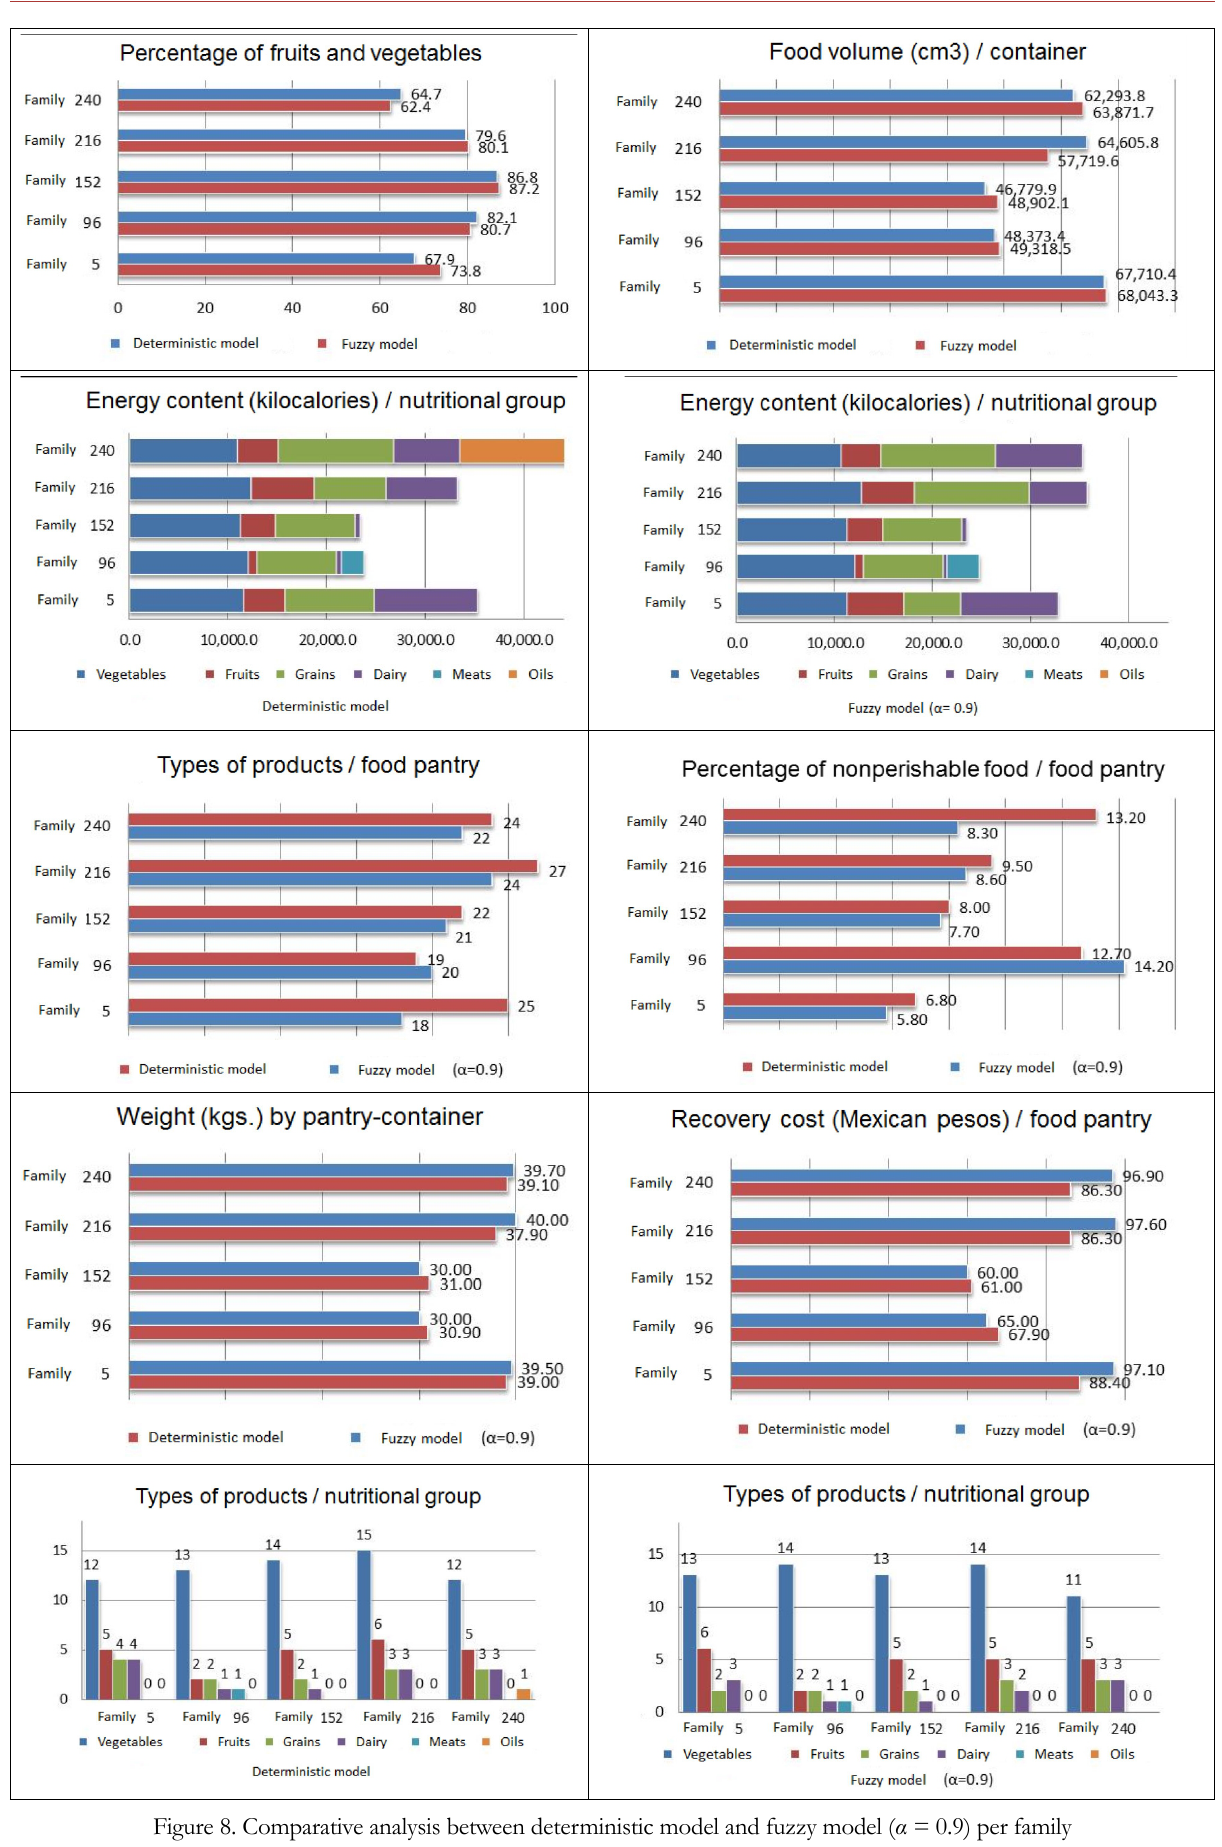
Figure 8. Comparative analysis between deterministic model and fuzzy model ( α = 0.9) per